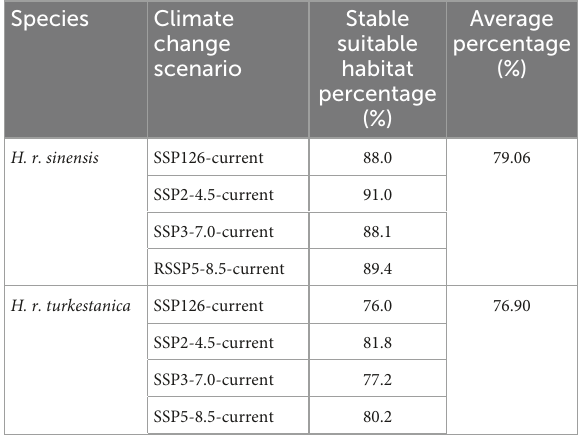
TABLE 4 Stable habitat percentage under different climate scenarios in the 2050s.